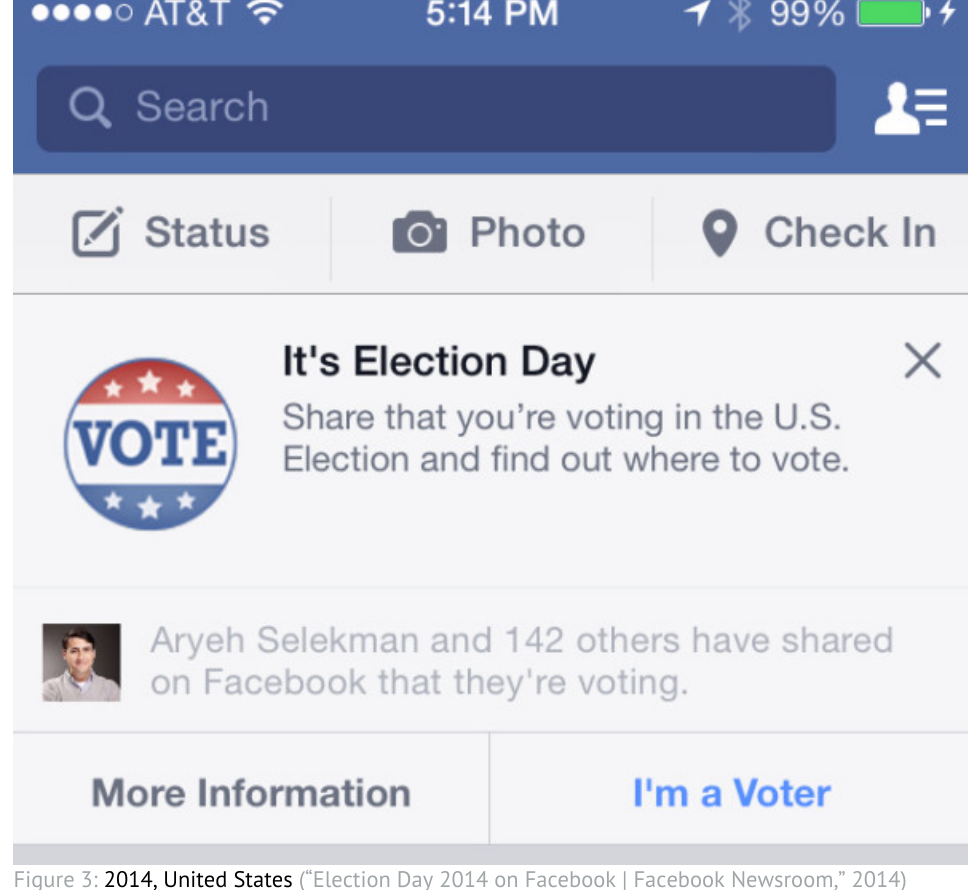
Figure 3: 2014, United States (“Election Day 2014 on Facebook | Facebook Newsroom,” 2014)